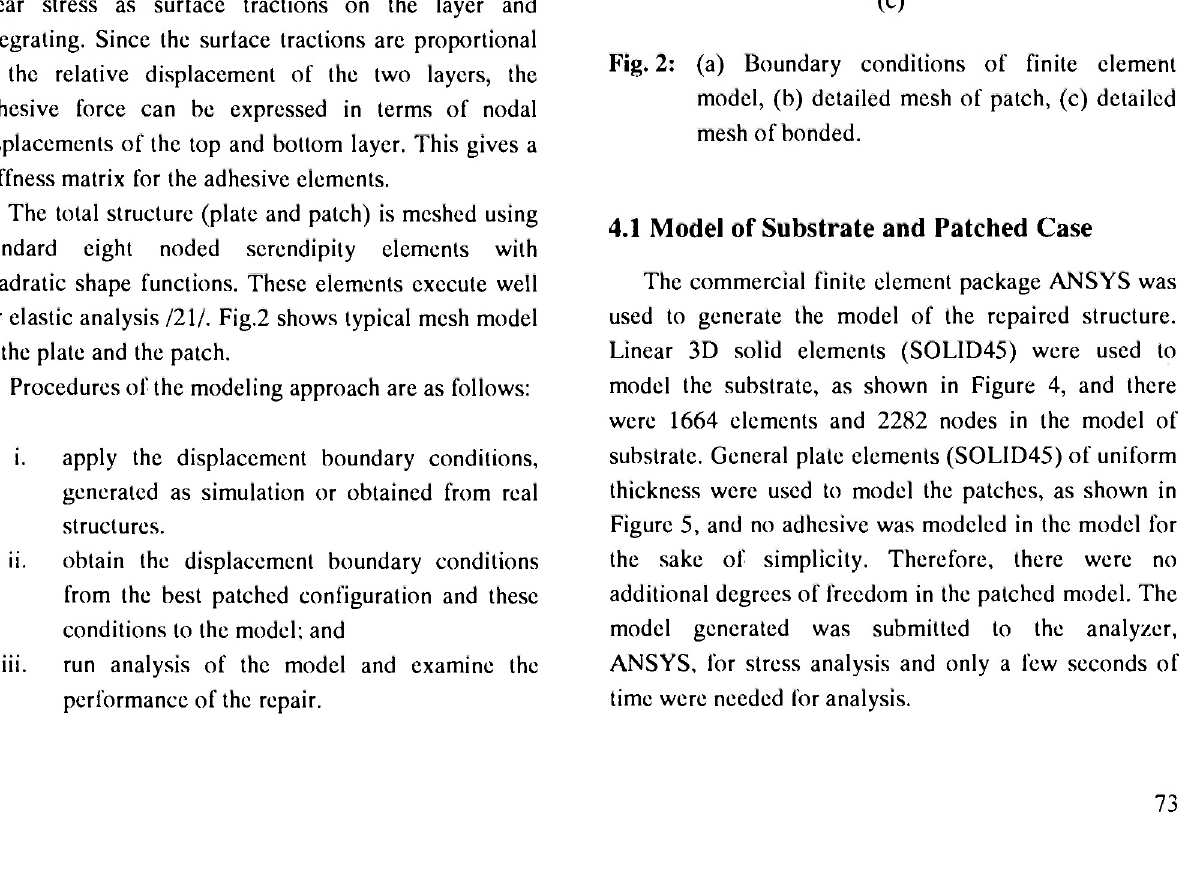
Fig. 2: (a) Boundary conditions of finite element model, (b) detailed mesh of patch, (c) detailed mesh of